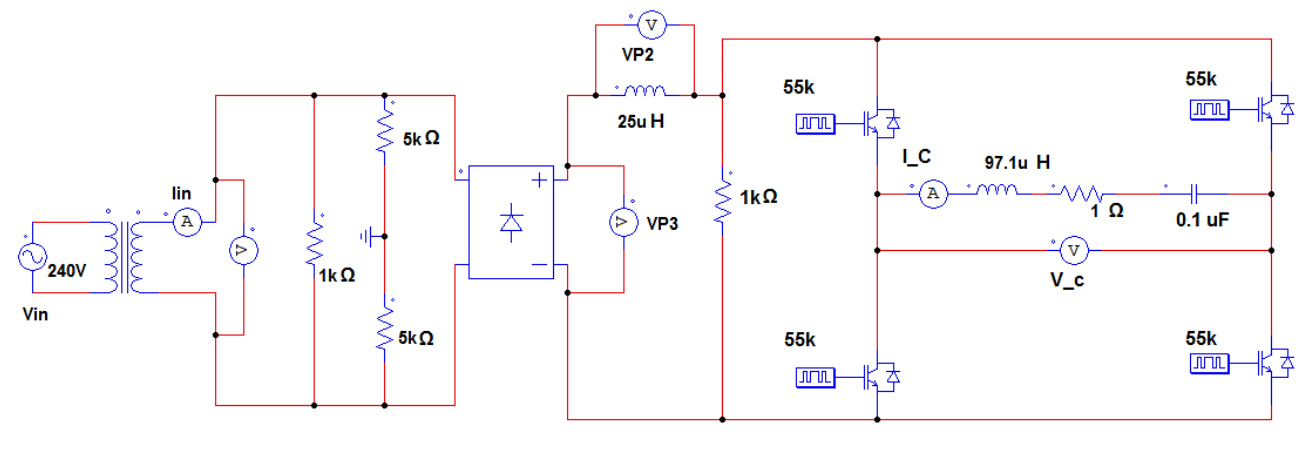
Figure 3. Simulation diagram of IH system without application of Boost